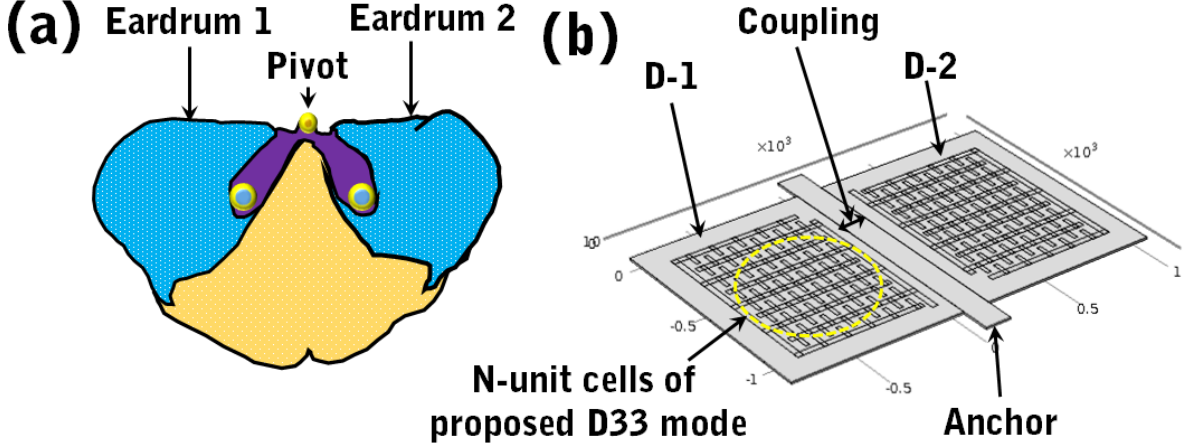
Figure 5. Bio-inspired piezoelectric microelectromechanical system (MEMS) directional microphone, ( a ) schematic of the fly Ormia ochracea ’s ear, redrawn from [8], and ( b ) directional microphone that imitates the fly Ormia ochracea ’s